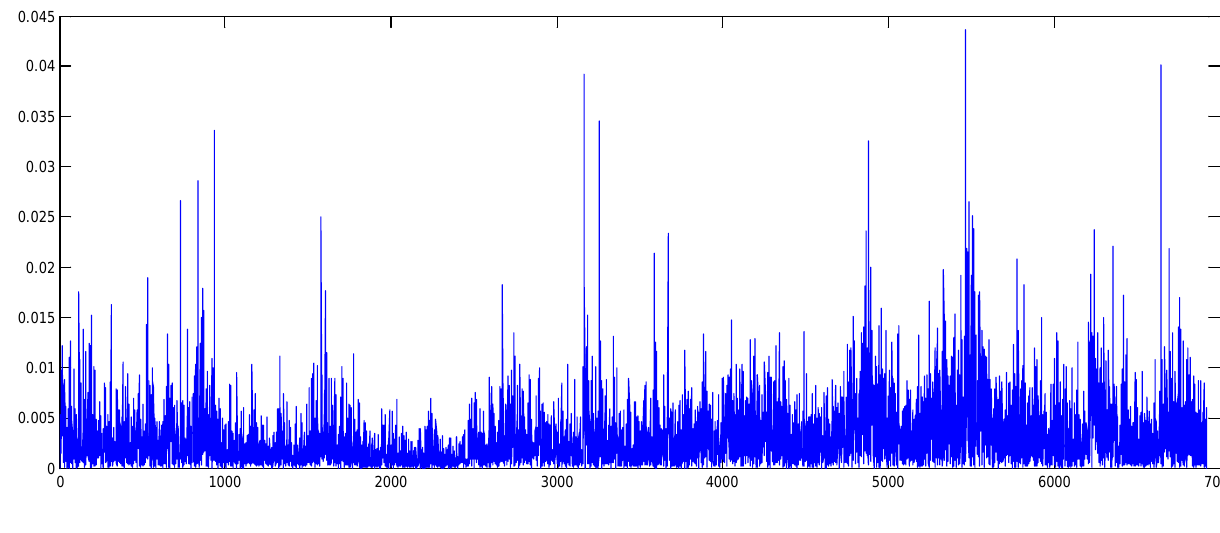
Figure 6. Gold absolute returns (original data).